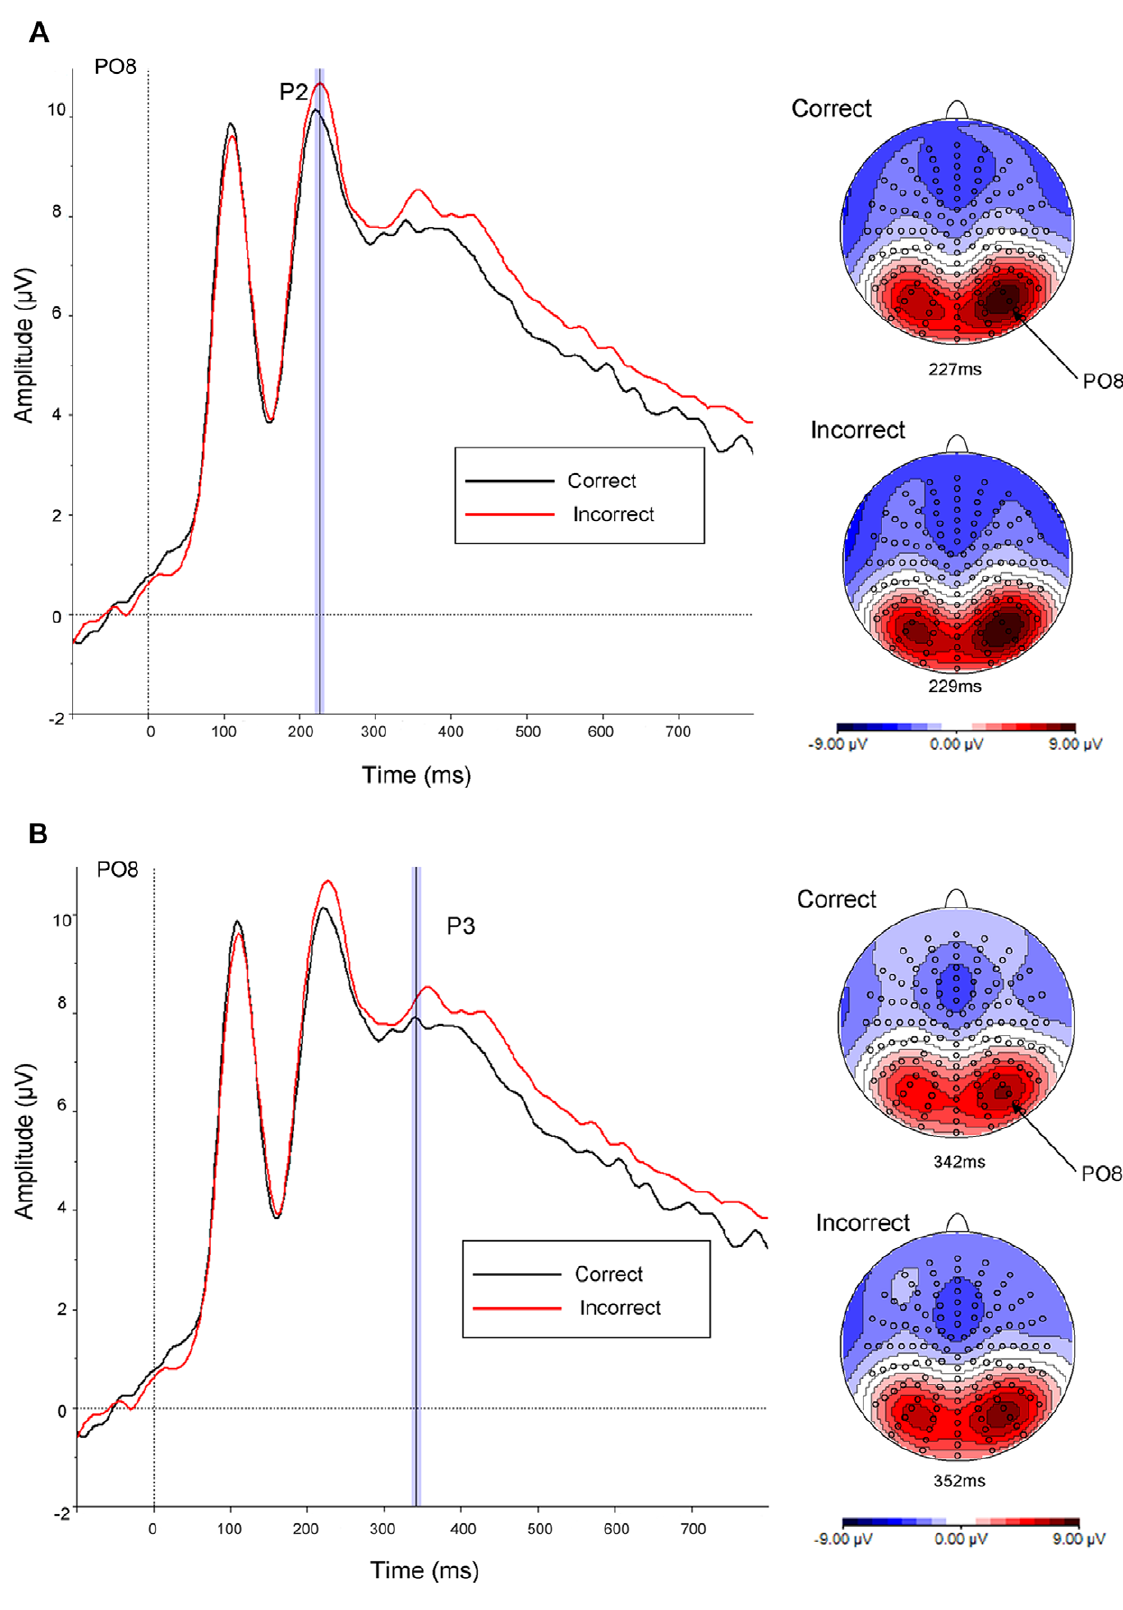
Figure 3. ERP Colour effects. Grand average ERPs to correctly (black line) and incorrectly (red line) coloured objects plotted between 2 100 and 800 msec with (a) topography associated with the peak amplitude for correctly versus incorrectly coloured objects for the P2; and (b) topography associated with the peak amplitude for correctly versus incorrectly coloured objects for the P3. doi:10.1371/journal.pone.0048550.g003 PLOS ONE |